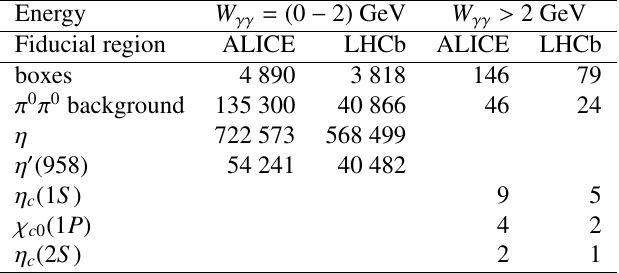
Table 1. Total nuclear cross section in nb. Only ”standard” cuts for ALICE and LHCb are